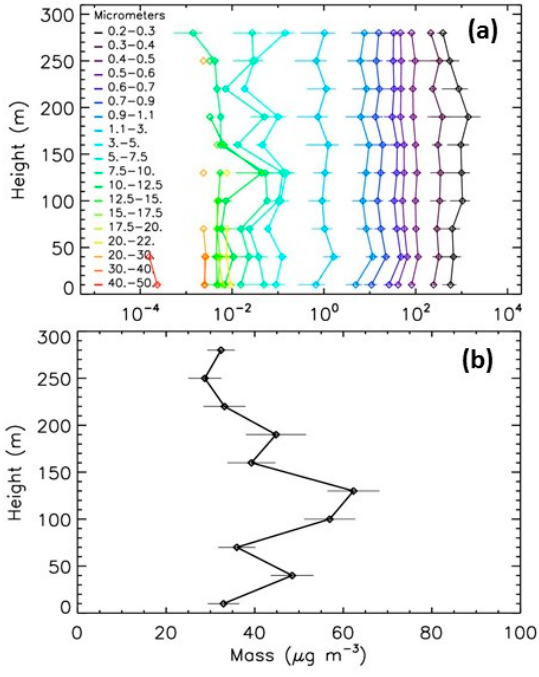
Figure 10. Evolution with height of LOAC concentrations for the 11 December 2013 pollution event. ( a ) number concentrations; ( b ) PM10 mass concentration.